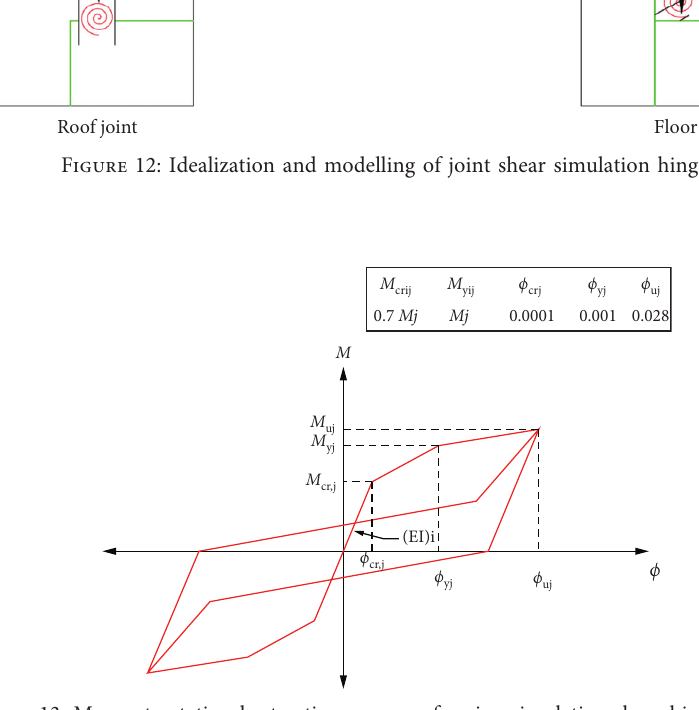
Figure 13: Moment-rotation hysteretic response of spring simulating shear hinge in joints.